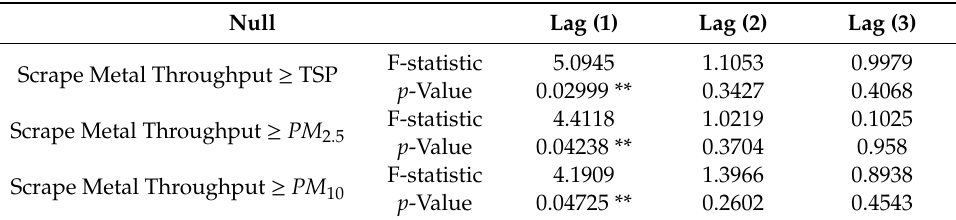
Table 5. Granger causality of scrap metal throughput and fine dust. Null